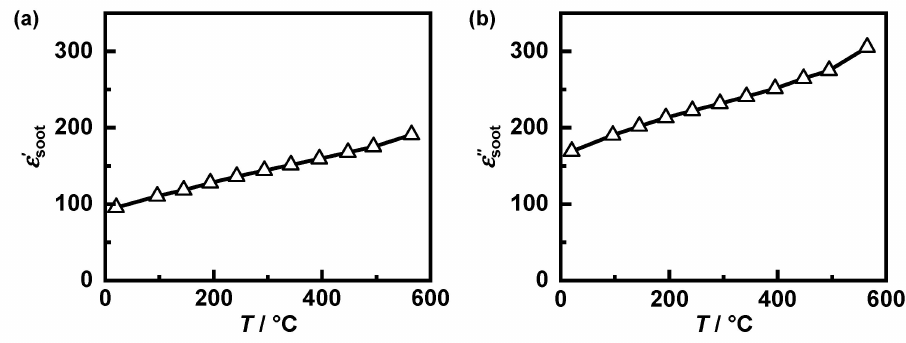
Figure 10. Dielectric properties (( a ) permittivity; ( b ) dielectric losses) of soot generated on the engine test bench at load corresponding to a velocity at 160 km/h depending on its